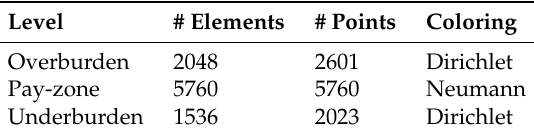
Figure 25. Mortar ( left ) and non-mortar ( right ) meshes. Table 8. Grids for Example 3 in Section 5.3.